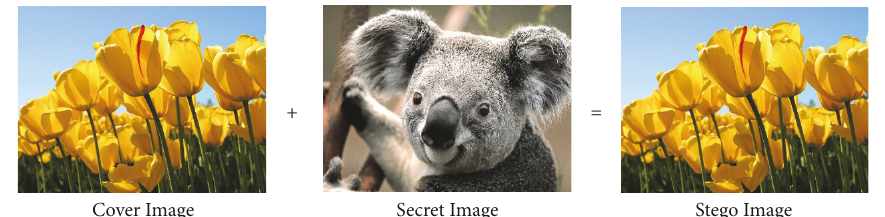
Figure 8: Encoding by previous method.